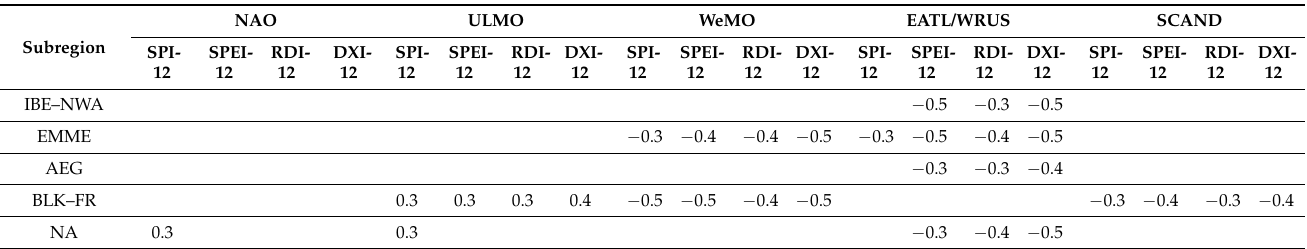
Table 9. Correlation coefficients between the percent areas in drought identified by SPI-12, SPEI-12 and RDI-12 and ATPs (only coefficients significant at 95% confidence level are